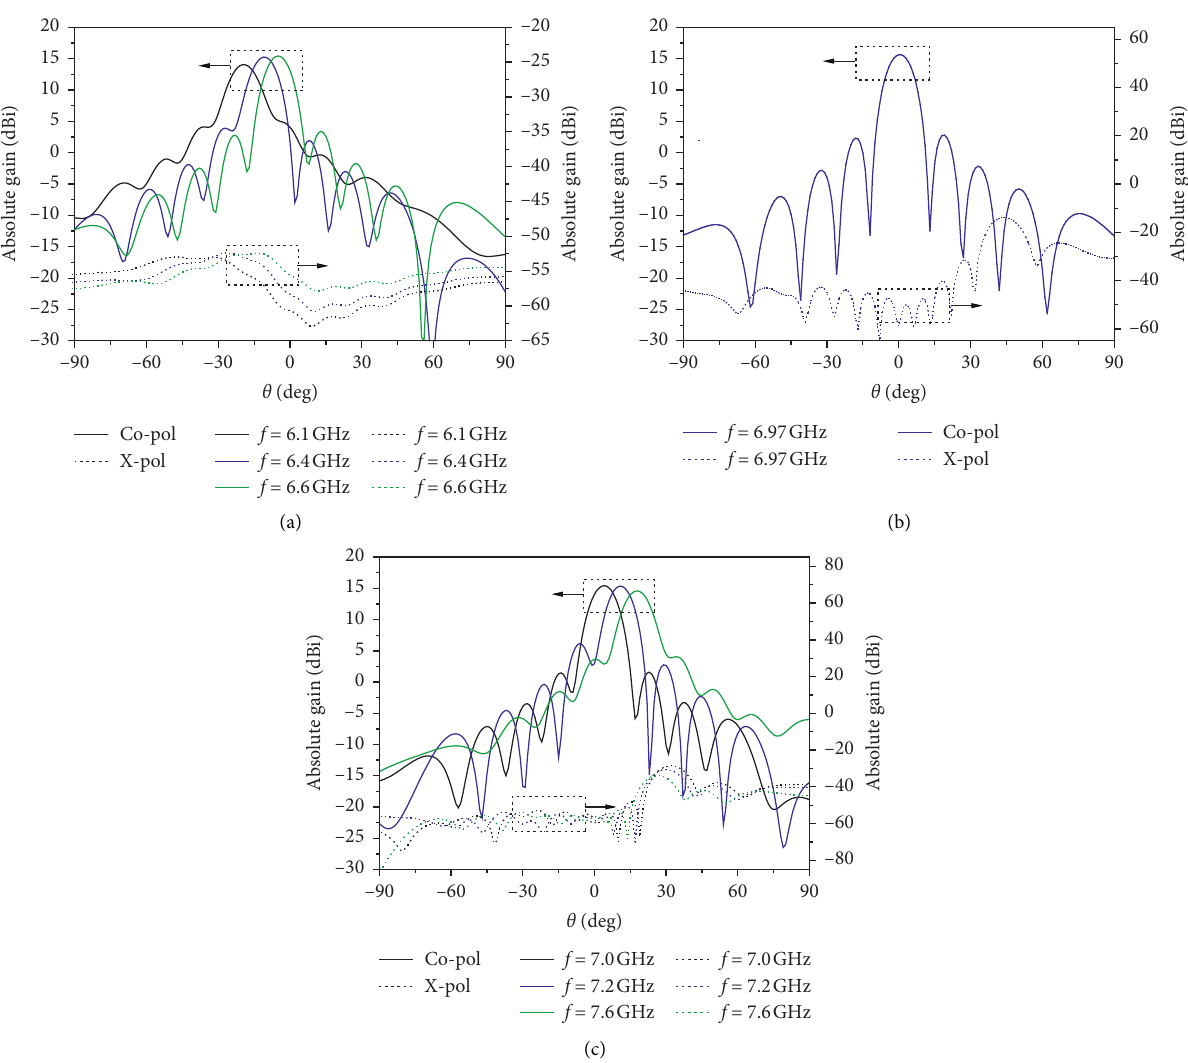
Figure 4: Simulated radiation patterns in the H -plane: (a) LH region; (b) broadside; (c) RH region.